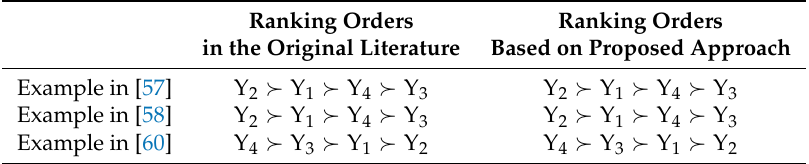
Table 10. A comparison of preference order for different